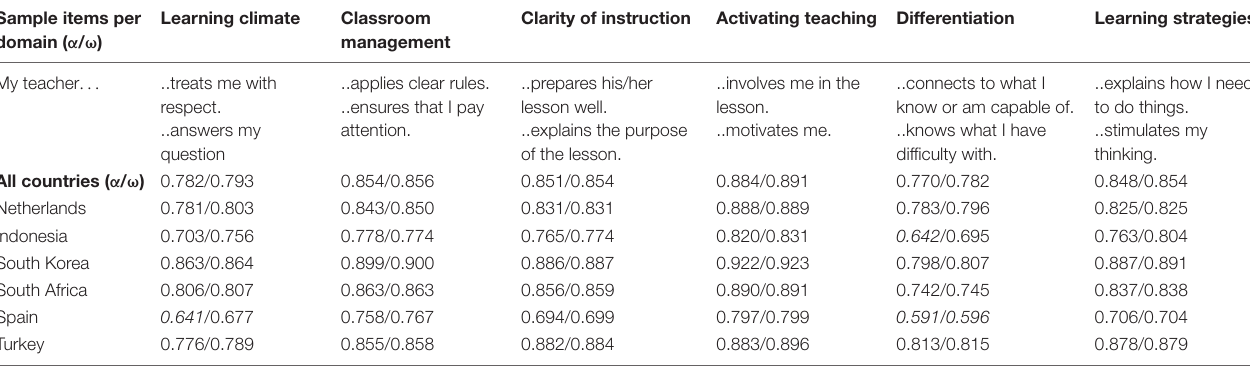
TABLE 3 | Example of items and reliability analysis (Cronbach’s α and McDonald’s ω ) on the six subscales based on student